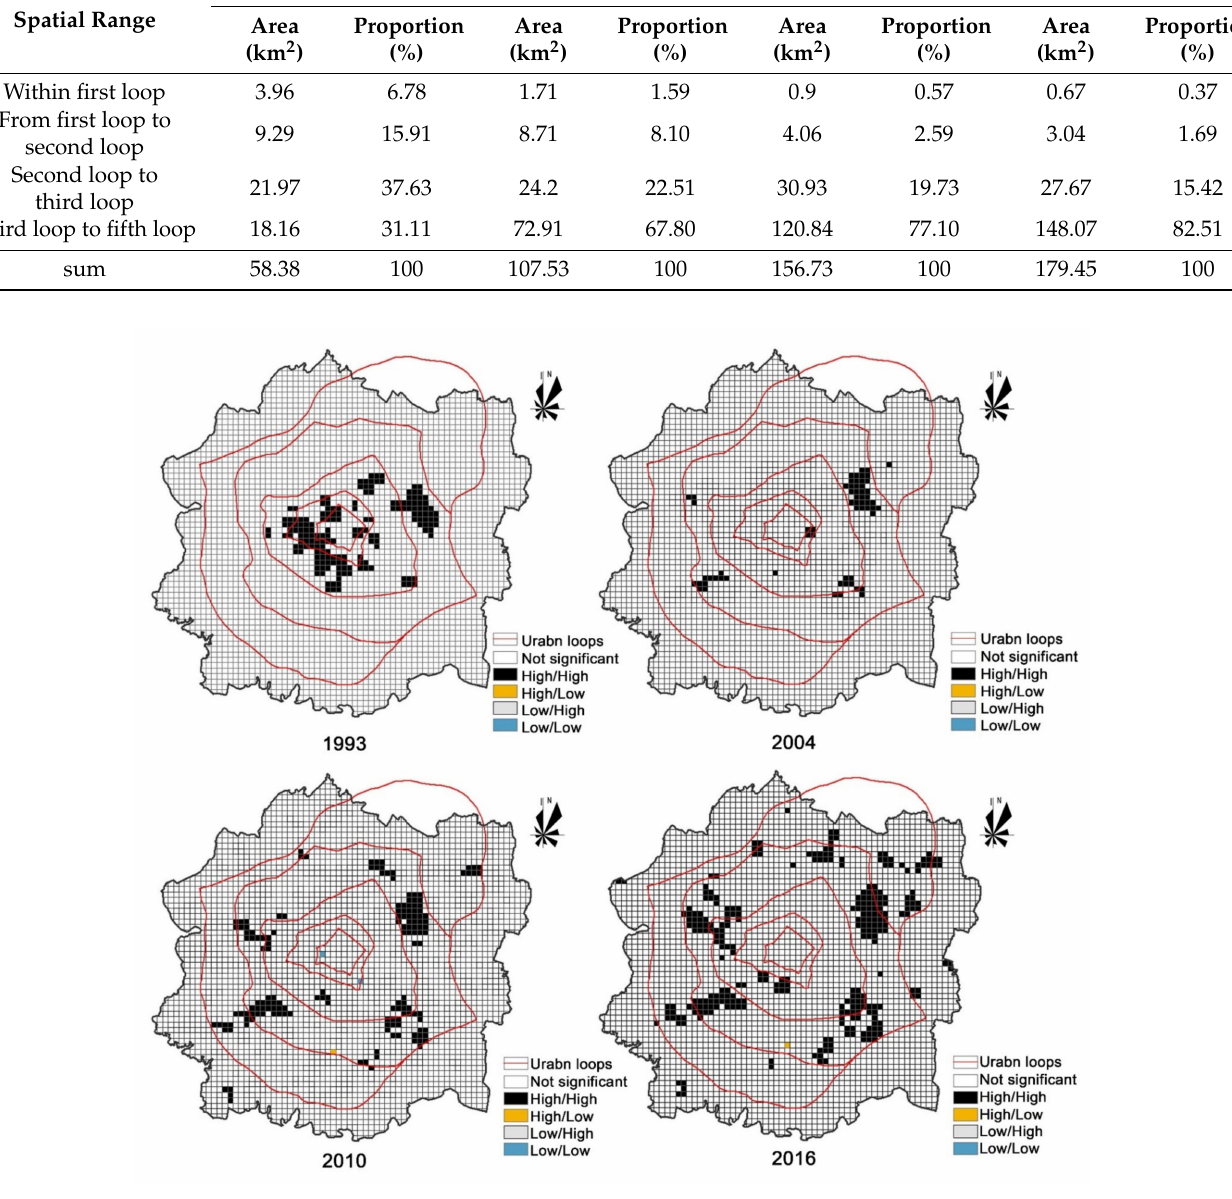
Figure 3. Clustering and outlier analysis of manufacturing land in the Wuhan metropolitan area since the